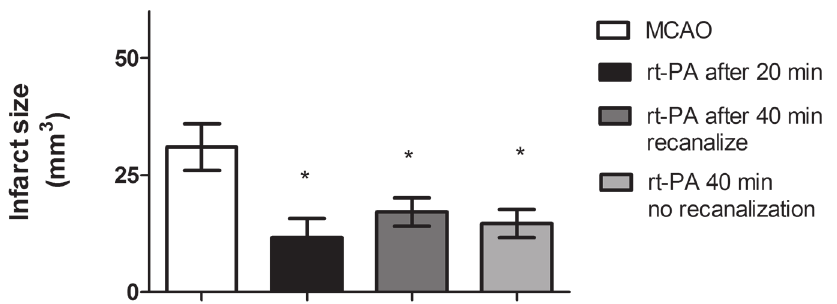
Figure 3. Size of infarct volume. Treatment with rt-PA significantly reduced the infarct volume compared to MCAO. Data are expressed as mean 6 s.e.m.; n=5–9 *P # 0.05, significant difference between treated groups and MCAO groups. Statistical analyses were performed using Kruskal-Wallis non-parametric test together with Dunn’s post-hoc test.